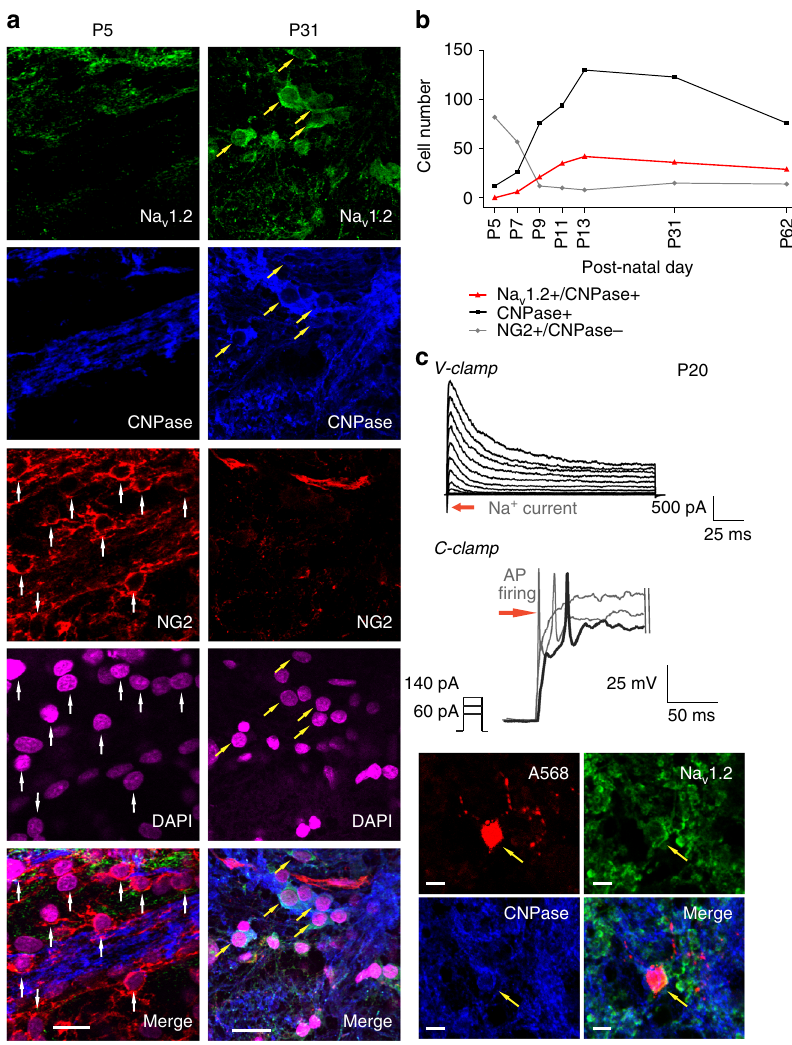
Fig. 7 The population of excitable pre-OLs increases during early postnatal development in the MNTB. a Immunostaining for Na v 1.2 channels ( green ), CNPase ( blue ) and NG2 ( red ) as well as DAPI staining ( magenta ) in the MNTB at P5 and P31. Yellow arrows indicate CNPase+/Na v 1.2+ pre-OLs, and white arrows indicate NG2+ cells. Scale bar , 20 μ m. b Total number of NG2+/CNPase – cells ( gray ), CNPase+ cells ( black ), and Na v 1.2+/CNPase+ cells (excitable pre-OLs, red ) from three slices (from four different brains) each at P5, P7, P9, P11, P13, P31, and P62). c Voltage-activated K + and Na + currents in response to step depolarization ( − 80 to 40 mV) in an excitable pre-OL ( left ) at P20. The same pre-OL exhibited APs in response to current injections (60 – 140 pA). Post-recording immunostaining revealed that the same cell (loaded with Alexa 568, red , arrow ) expressed CNPase ( blue ) and Na v 1.2 ( green ). Scale bar , 10 μ